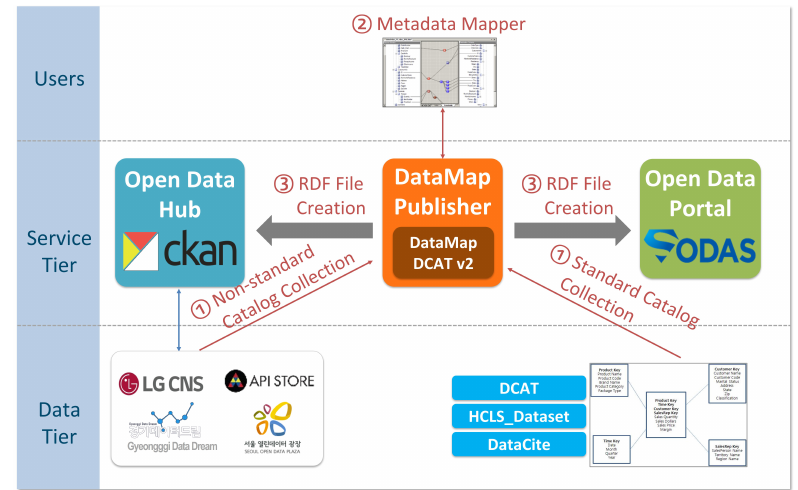
Figure 9. Operation of metadata conversion tool.